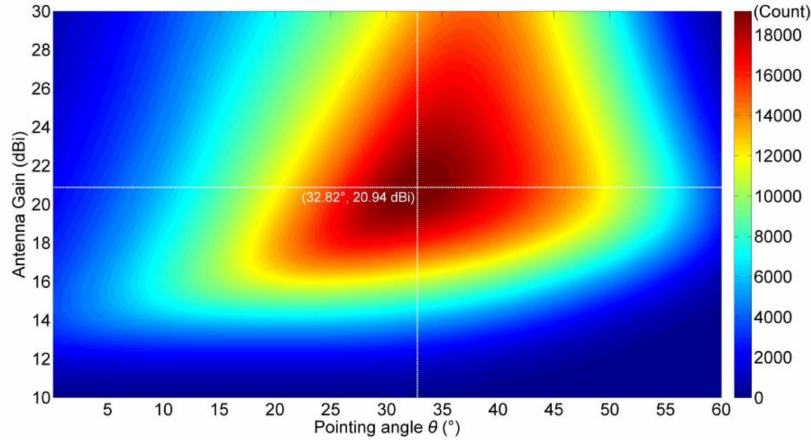
Figure 7. The number of available SPs in a comprehensive sea state.